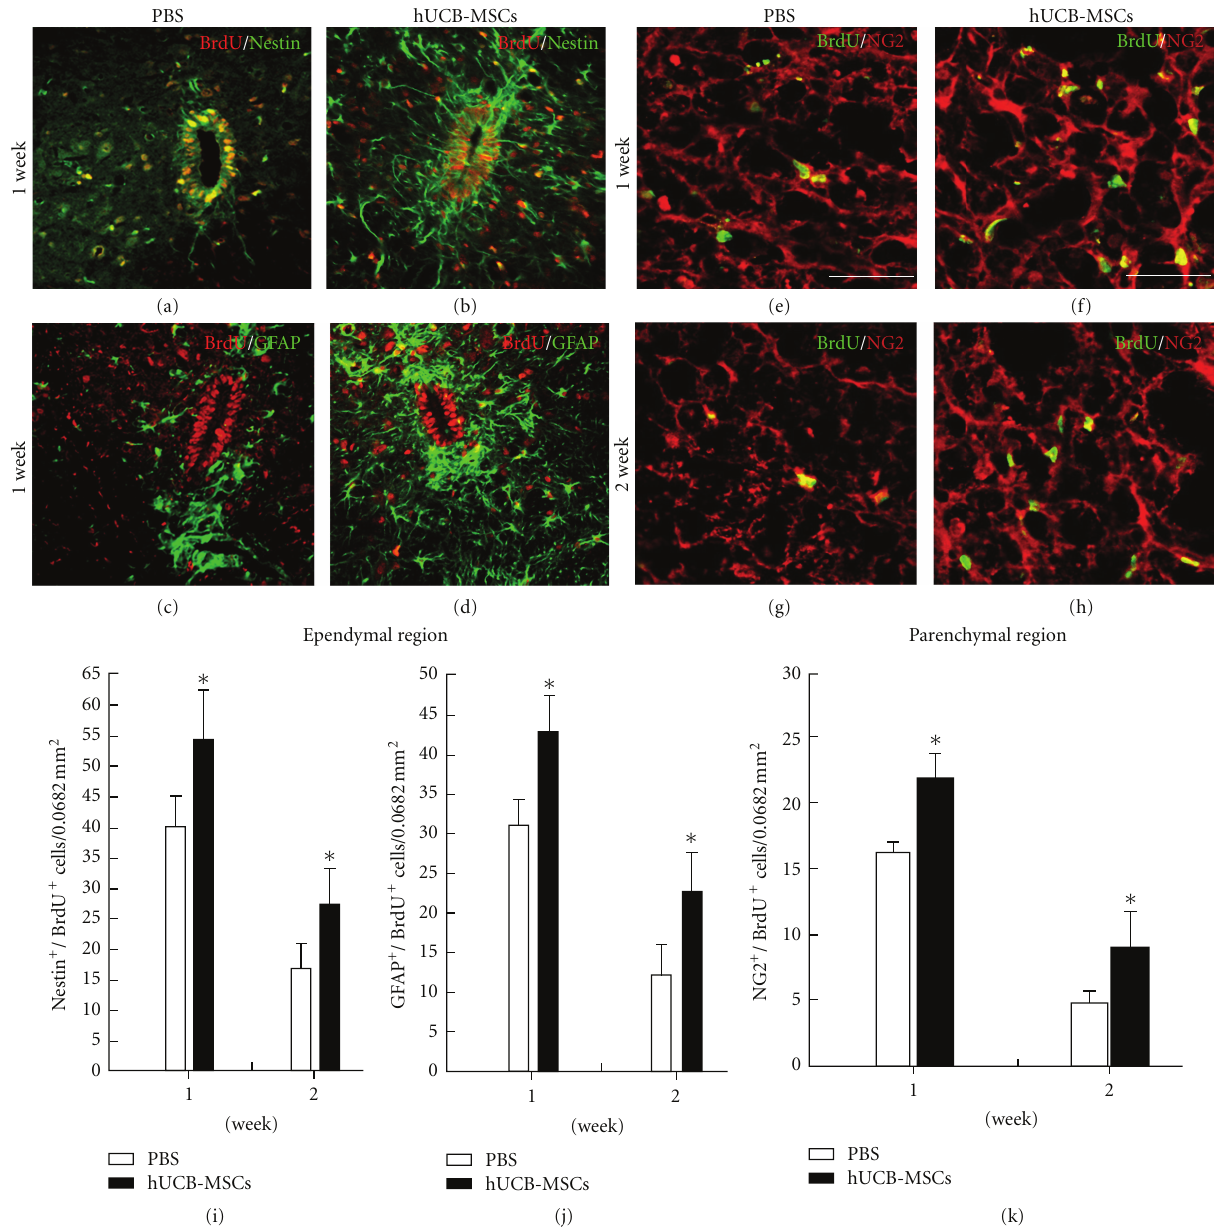
Figure 3: Endogenous neurogenesis induced by transplantation. Endogenous stem cells were assessed quantitatively by double staining of BrdU with nestin, GFAP, and NG2 at 1 and 2 weeks after transplantation in both the ependymal and parenchymal regions. (a)–(d) At 1 and 2 weeks following transplantation, BrdU/nestin-labeled cells as well as BrdU/GFAP-labeled astrocytes were present in ependyma. (e) and (h) BrdU-labeled NG2 cells were coexpressed at 1 and 2 weeks in the parenchyma. (i) and (j) The numbers of BrdU-labeled ependyma coexpressing GFAP/nestin were quantified at 1 and 2 weeks after transplantation. (k) The numbers of BrdU-labeled parenchyma coexpressing NG2 were quantified at 1 and 2 weeks after transplantation. ∗ P < 0 . 05, scale bars = 10 µ m in (a)–(d); 20 µ m in (e)–(h).